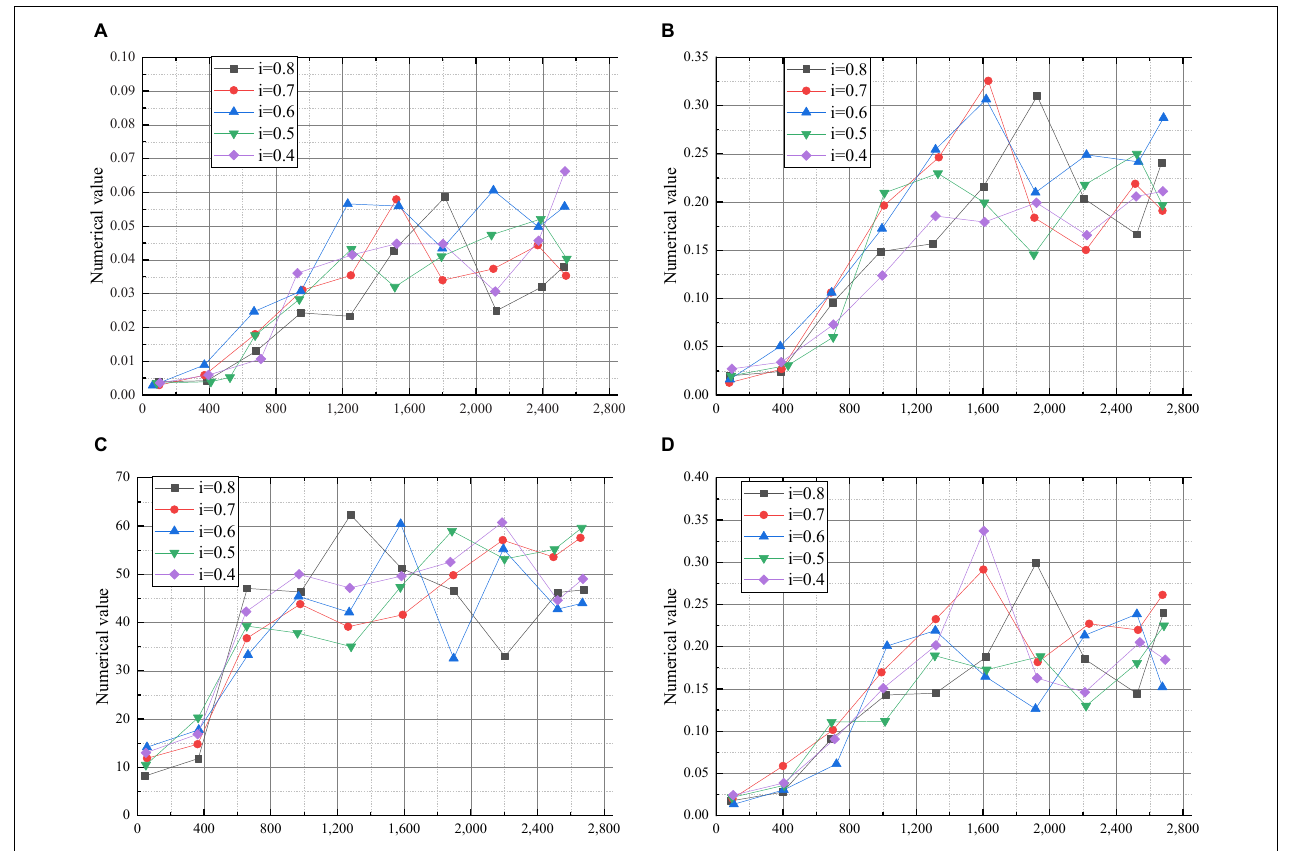
FIGURE 4 | Dropout experiment ( A: Recall rate; B: Predict the next test question; C: Test coverage; D: Quality of test questions; i : Dropout value).